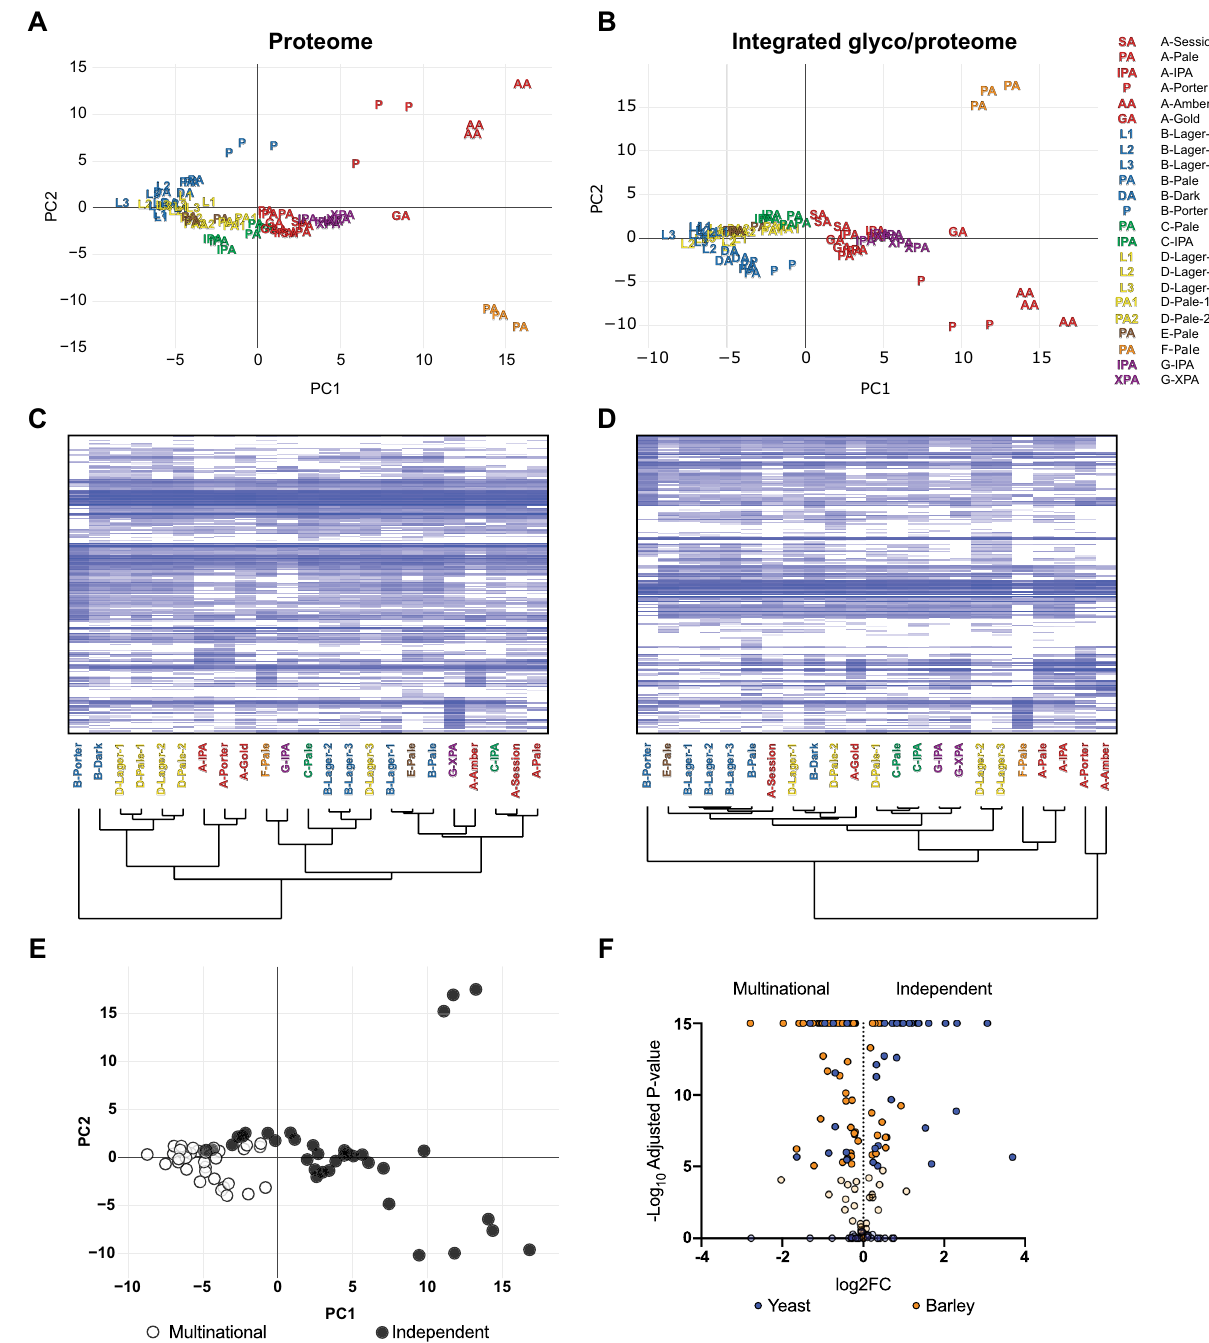
Figure 2. The global glyco/proteomes of commercial beers. ( A ) PCA of beer proteomes without (PC1 18.86% and PC2 9.87%) or ( B ) with consideration of glycation and glycosylation (PC1 18.62% and PC2 9.52%). ( C ) Clustered heat map of beer proteomes without or ( D ) with consideration of glycation and glycosylation. Dendrograms show sample clustering by brewery ( A – G ) and beer style. PCAs and heatmaps use log 10 protein abundance normalised to total protein abundance in each sample. ( E ) PCA of beer glyco/proteomes as in ( B ) but with beers classified as either produced by multinational (white circles) or independent (black circles) breweries. ( F ) Volcano plot of the comparison of the glyco/proteomes of beers produced by multinational or independent breweries. Blue, yeast proteins; orange, barley proteins; 100% opacity, significantly different proteins; 20% opacity, non-significantly different proteins; positive Log 2 FC, significantly more abundant in beers from independent breweries; negative Log 2 FC, significantly more abundant in beers from multinational